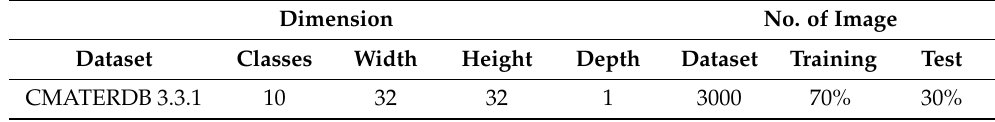
Table 2. Dataset description.